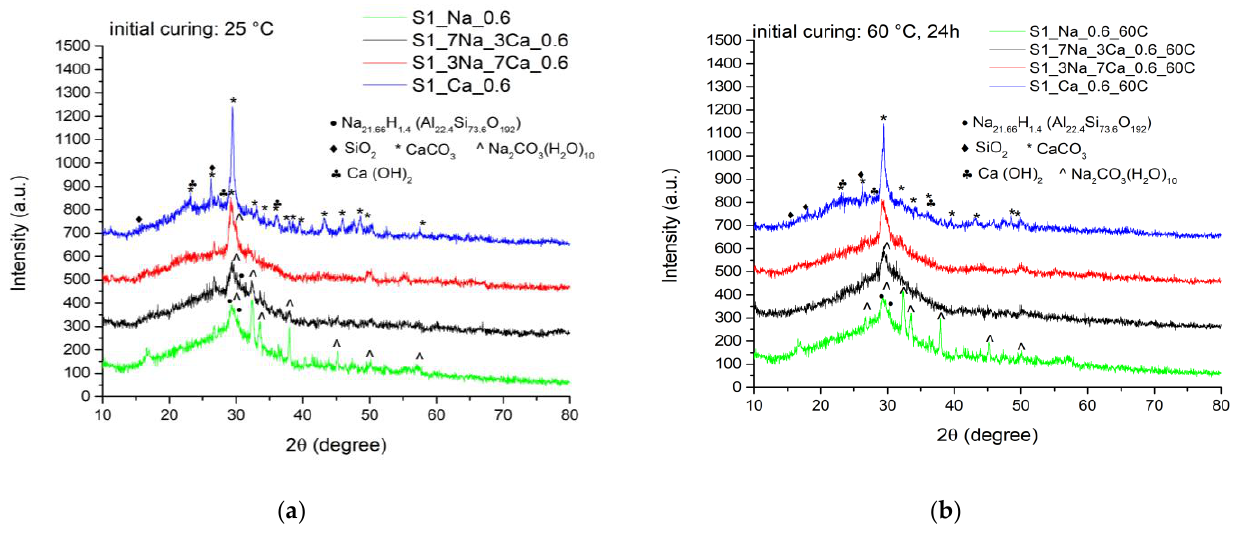
Figure 3. XRD patterns recorded after 28 days of hardening for samples obtained with S1 glass powder stored at 25 ◦ C ( a ) and cured first at 60 ◦ C for 24 h and then at 25 ◦ C ( b ). Figures 4 and 5 show the microstructures of G-AAIPs hardened in different condi- tions. On the SEM images one can assess two types of morphology: well-definite rectan- gular shapes characteristic for sodium silicate hydrates (see inserts on SEM images for samples S1_Na_0.6—Figure 4 and S2_Na_0.6—Figure 5) and fibrillar and foil-like struc- tures specific to C-S-H (see arrows) in rich calcium samples (S1_Ca_0.6 and S1_3Na_7Ca_0.6—Figure 4).